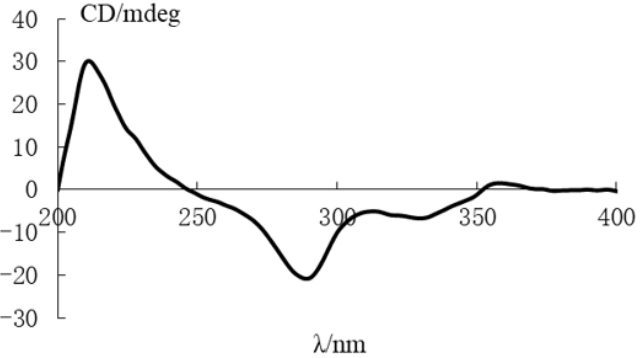
Figure 5. The ECD spectrum of 1 .